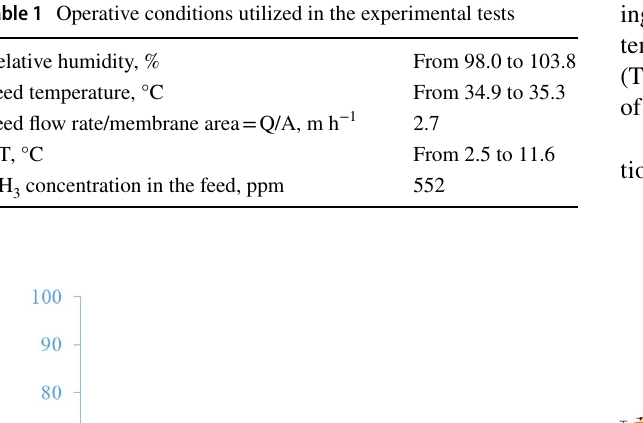
2.5 °C ≤ ΔT ≤ 11.6 °C; NH 3,Feed = 522 ppm; Q/A = 2.7 m/h. Model: 98.0% ≤ RH Feed ≤ 103%; T Feed = 35.1 °C; NH 3,Feed = 522 ppm; Q/A = 2.7